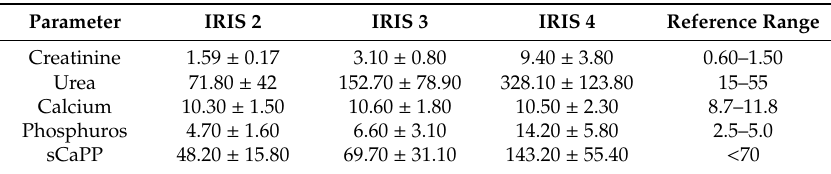
Table 1. Mean values and standard deviation (SD) of serum creatinine (mg / dL), urea (mg / dL), calcium (mg / dL), phosphate (mg / dL) and serum calcium-phosphorus concentration product (sCaPP) product (mg 2 / dL 2 ) for each International Renal Interest Society (IRIS) stage.